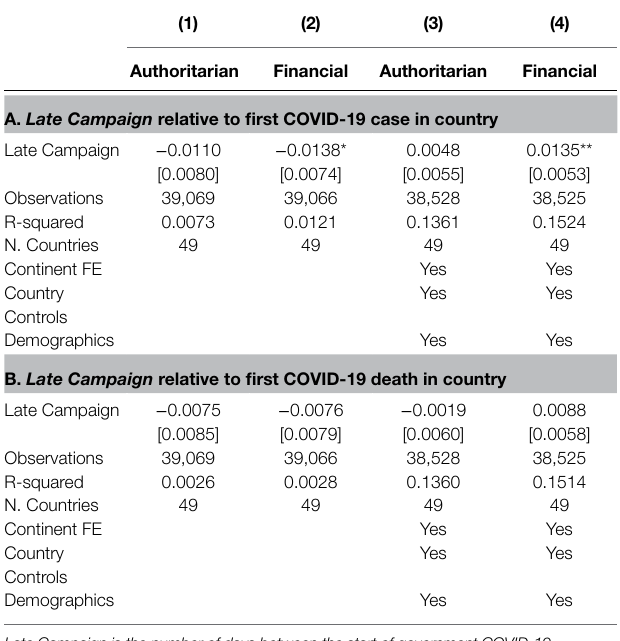
TABLE 2 | Main results from Study